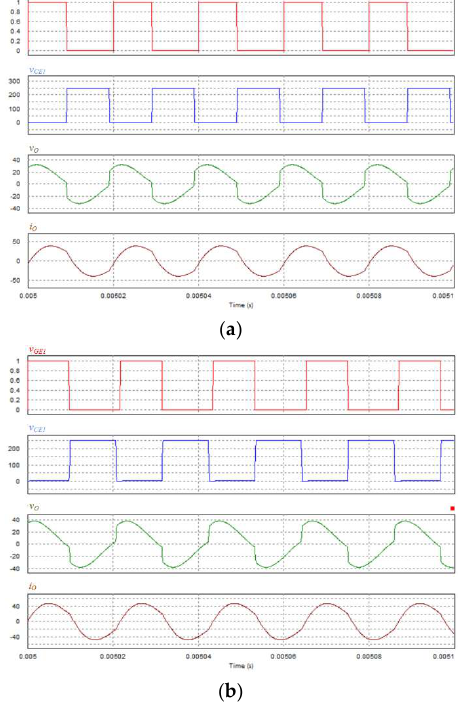
Figure 19. Simulation waveforms v GE1 (duty cycle), the voltage across the power switch voltage v CE1 , the output voltage v o , and the output current i o under the condition that the workpiece is 500 °C: ( a ) traditional control strategy, ( b ) proposed MPPT heating control strategy.